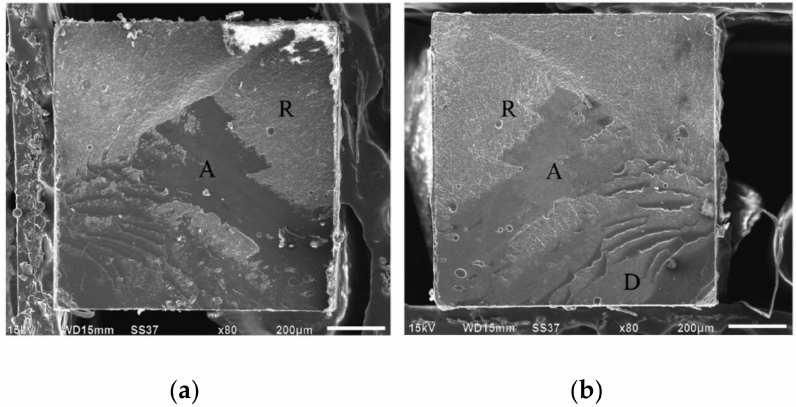
Figure 5. Representative SEM images of the surface of the debonded specimen: mixed failure of a specimen from the medium-grit group (A = adhesive, C = composite resin, D = dentin). ( a ) Debonded specimens on resin composite fracture site of mixed failure. ( b ) Debonded specimens on dentin fracture site of mixed failure.